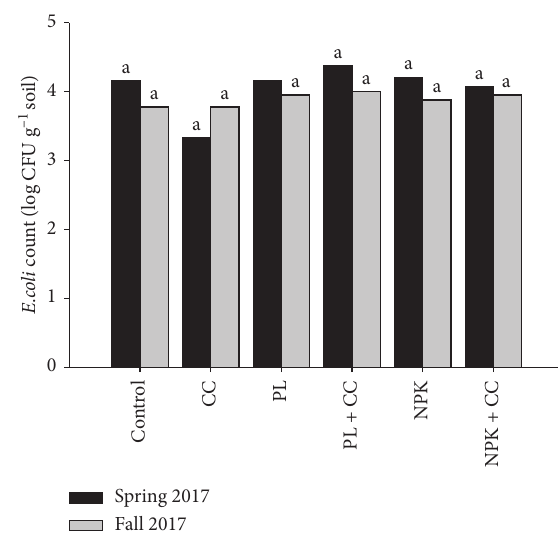
Figure 3: Treatment effects of poultry litter compost (PL) and chemical fertilizers (NPK) with or without cover crops (CC) and unamended control on the numbers of E. coli (logCFU · g − 1 soil) in Spring and Fall of 2017. Different letters above each bar indicate significant differences between treatments within a sample period at p < 0 . 05. There were no significant time or treatment effects.